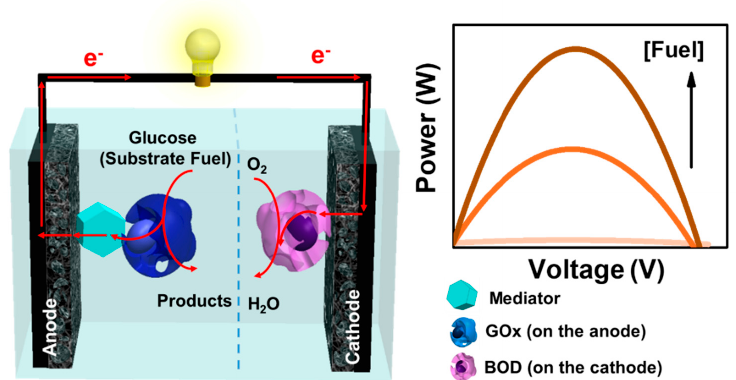
Figure 4. Illustration of a typical carbon-based glucose/oxygen BFC, showing the main components and principles involving enzymatic electro-oxidation and reduction on the anode and cathode, respectively. BFCs consist of a two-electrode cell, similar to other types of fuel cells. The BFC cell is separated by a medium, which could be an electrolyte and a separating membrane, which aids in conducting protons. However, because personalized devices require a miniaturized platform, a membraneless system is designed for simplicity.